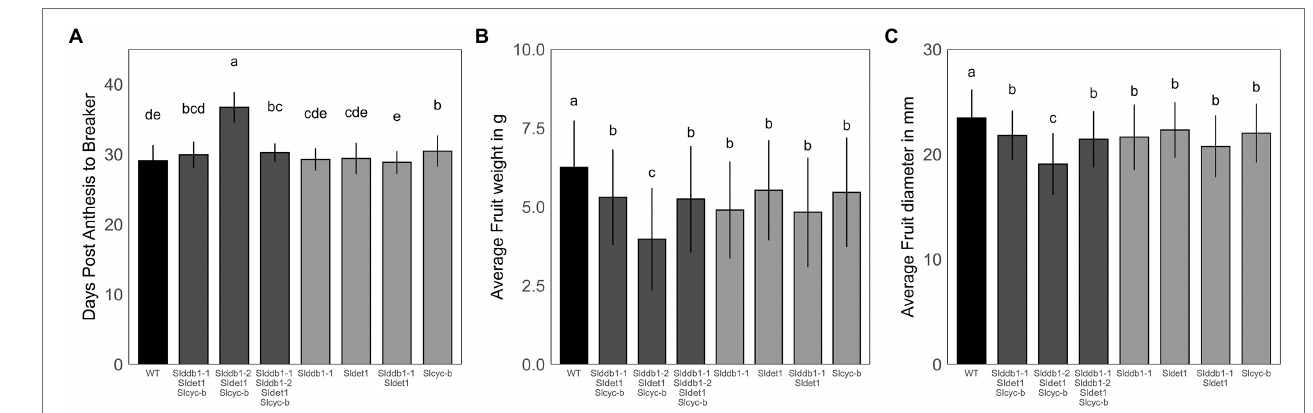
FIGURE 5 | Fruit development in segregating T 3 and BC 1 F 3 generations. Fruit development was measured at the post-mature green stage (28 DPA). (A) Fruit development from the anthesis stage (0 DPA) to the breaker stage, corresponding to the end of fruit growth and the beginning of maturation. (B,C) Fruit weight in g and equatorial size in mm measured at the post-break stage. Error bars indicate SD, and letters and upper bars indicate groups significantly different at p = 0.05 according to the SNK